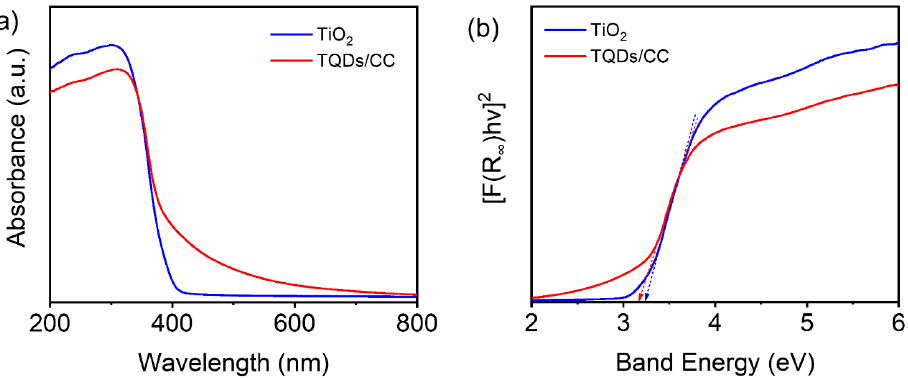
Figure 8. ( a ) UV-vis DRS spectra of TiO 2 and TQDs/CC-2.5 photocatalyst and ( b ) Kubelka–Munk plots as calculated from the DRS spectra.